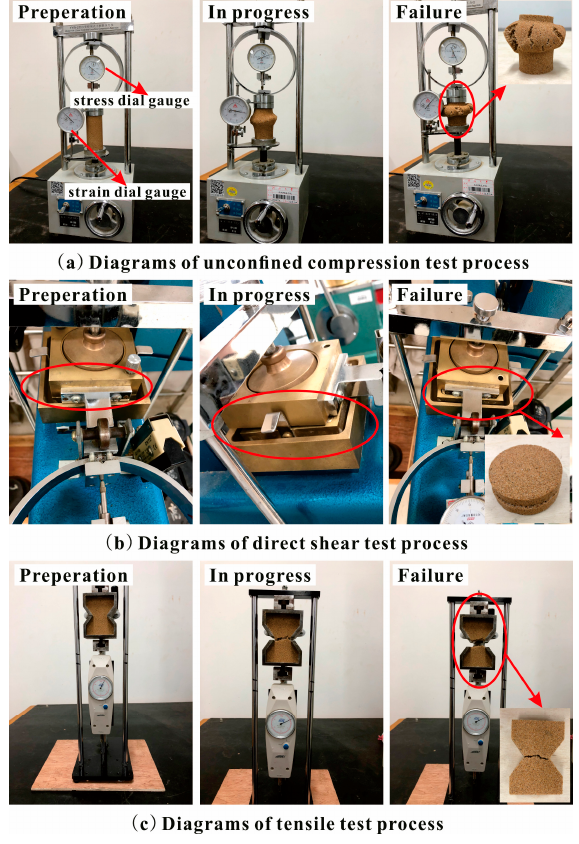
Figure 4. Diagrams of three tests: ( a ) UCS test; ( b ) Direct shear test; ( c ) Tensile test.